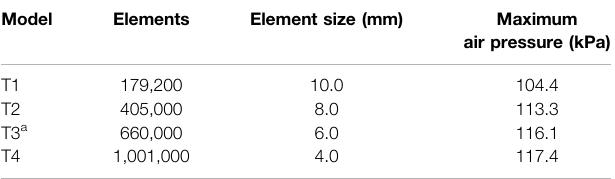
TABLE 2 | Summary of the mesh-convergence tests for the shock-tube